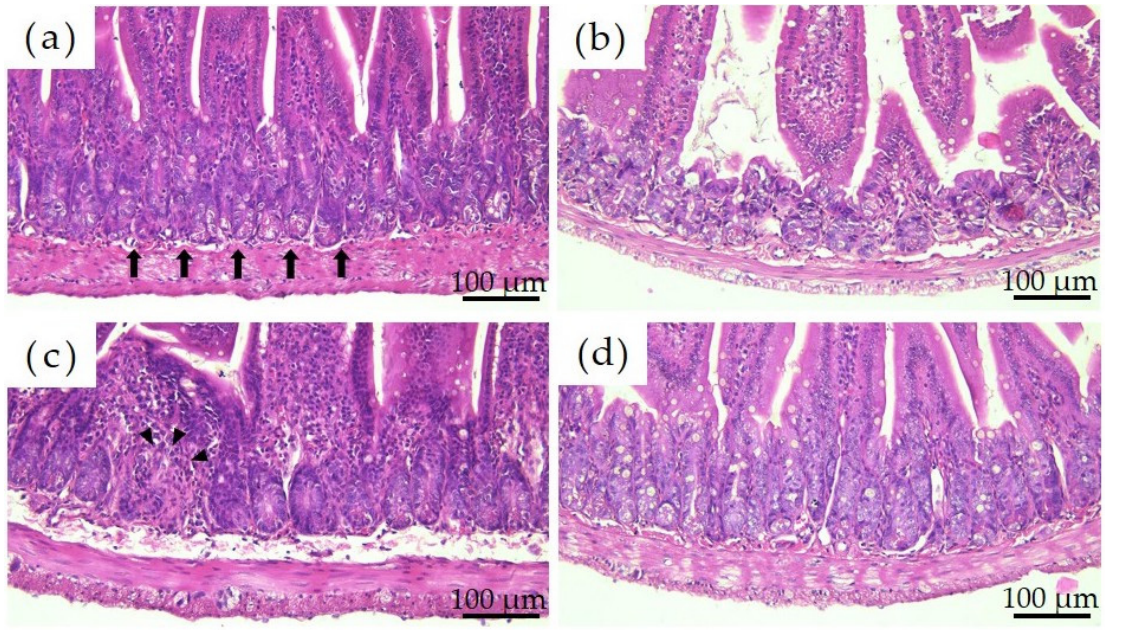
Figure 3. Comparison of the histology of the small intestine after repeated oral administration test. ( a ) PBS, ( b ) Ion, ( c ) nickel nanoparticles (Ni-NPs), and ( d ) nickel microparticles (Ni-MPs) groups. Histological observation based on hematoxylin and eosin staining showed significant atrophy and degeneration of glandular structures (black arrows) at the base of the epithelium in the Ion group compared with that observed in the PBS group. There was also some lack of continuity in the Ni-NPs group (black arrowheads). No notable changes were observed in the Ni-MPs group.